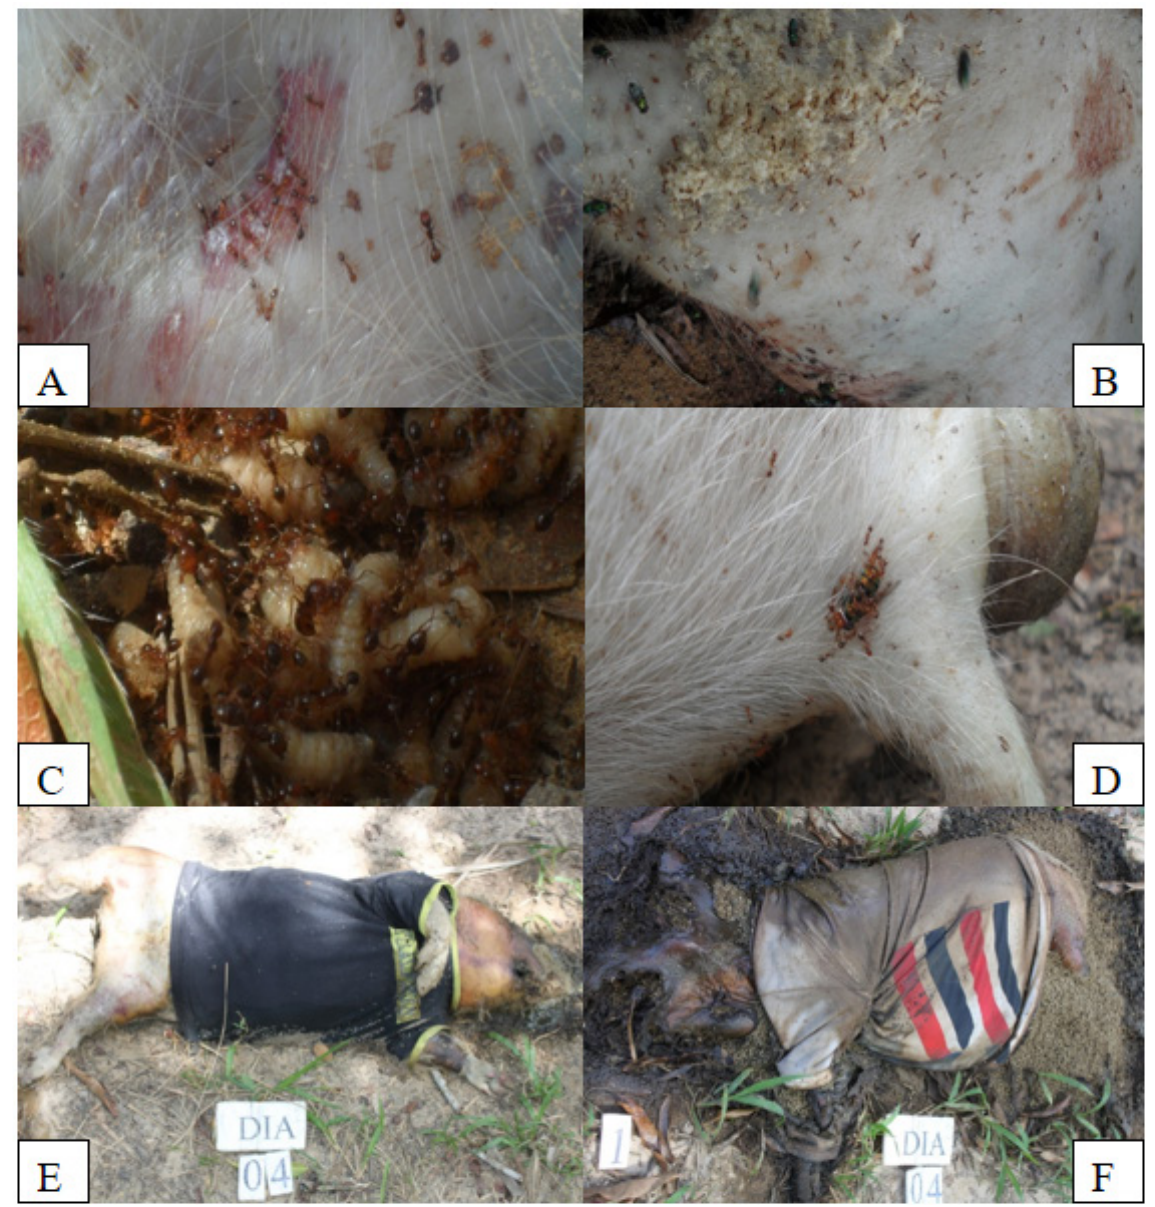
Fig 2 - Marks (A), predation to eggs (B), larvae (C) and adults (D) of Diptera caused by Solenopsis saevissima activity and difference in mass of fly larvae present in Sus scrofa carcasses with (E) and without (F) exposure to Solenopsis saevissima